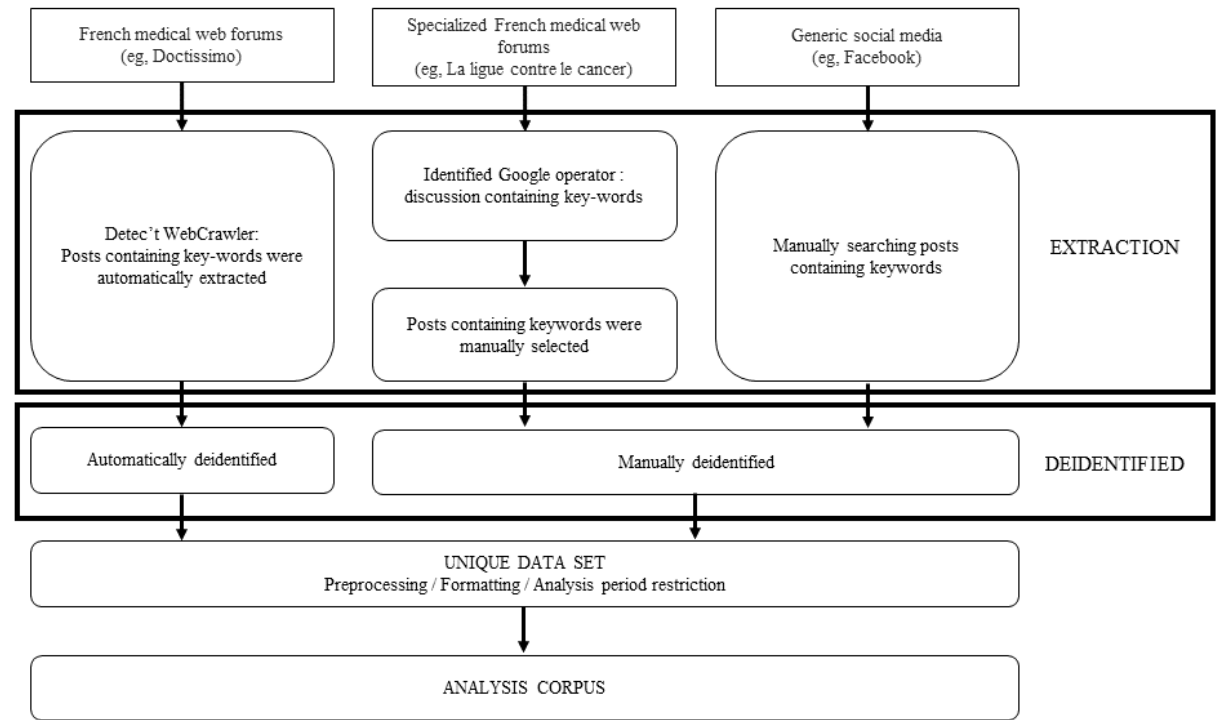
Figure 1. Diagram of the steps for creating the analysis